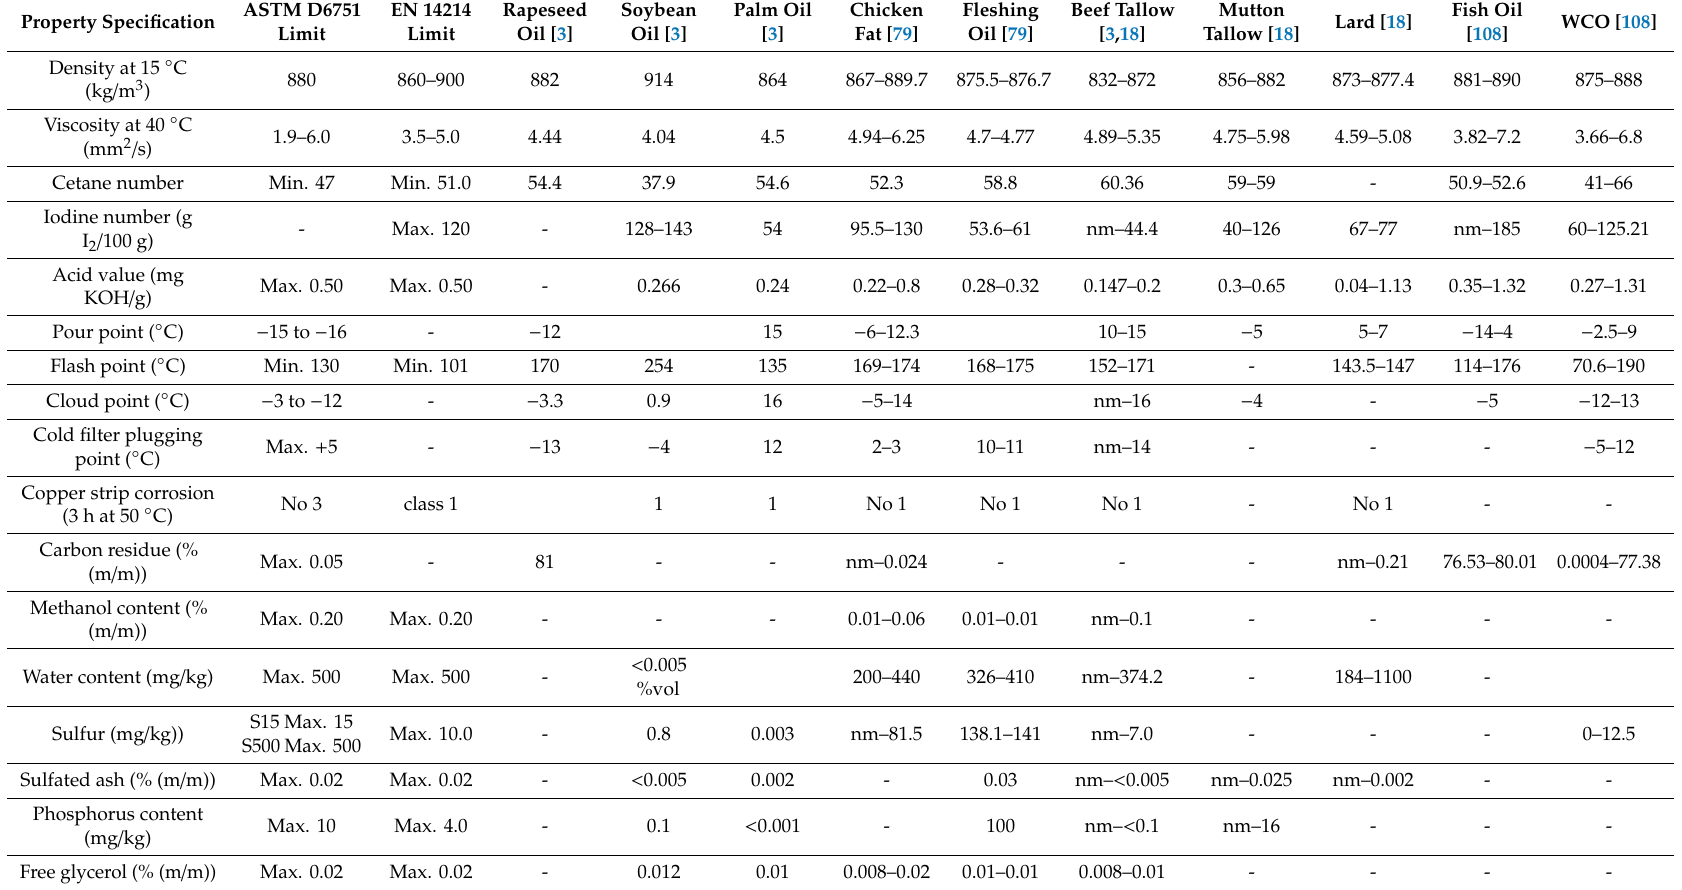
Table 10. Biodiesel properties from di ff erent